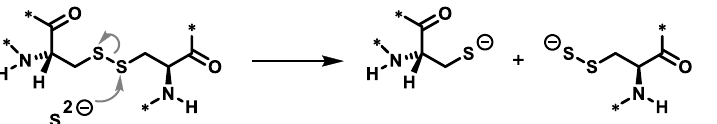
Figure 5. Reaction scheme for the disulphide bond cleavage by a S 2 − anion. The stars denote the continuation of the protein chain.